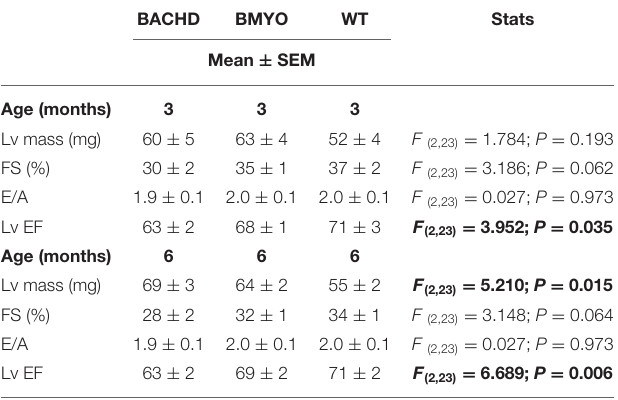
TABLE 1 | Echocardiographic parameters in BACHD, BMYO and WT animals at 3 and 6 months of age. BACHD